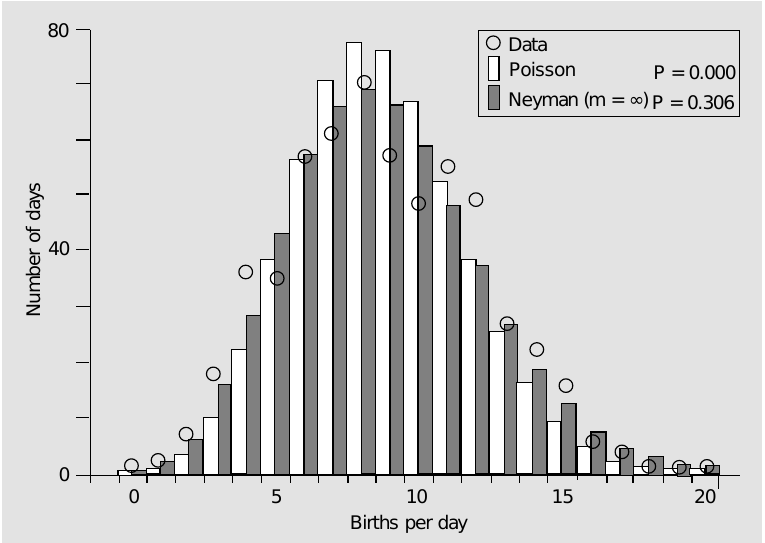
Figure 1. Number of days versus number of births per day. The distributions are indicated in the